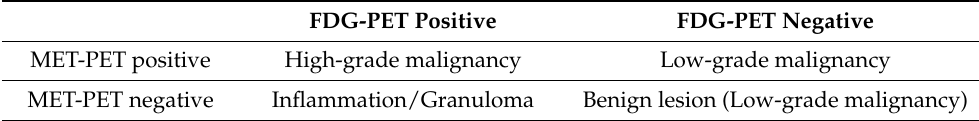
Table 1. Algorism of for cancer diagnosis combining FDG-PET and MET-PET.